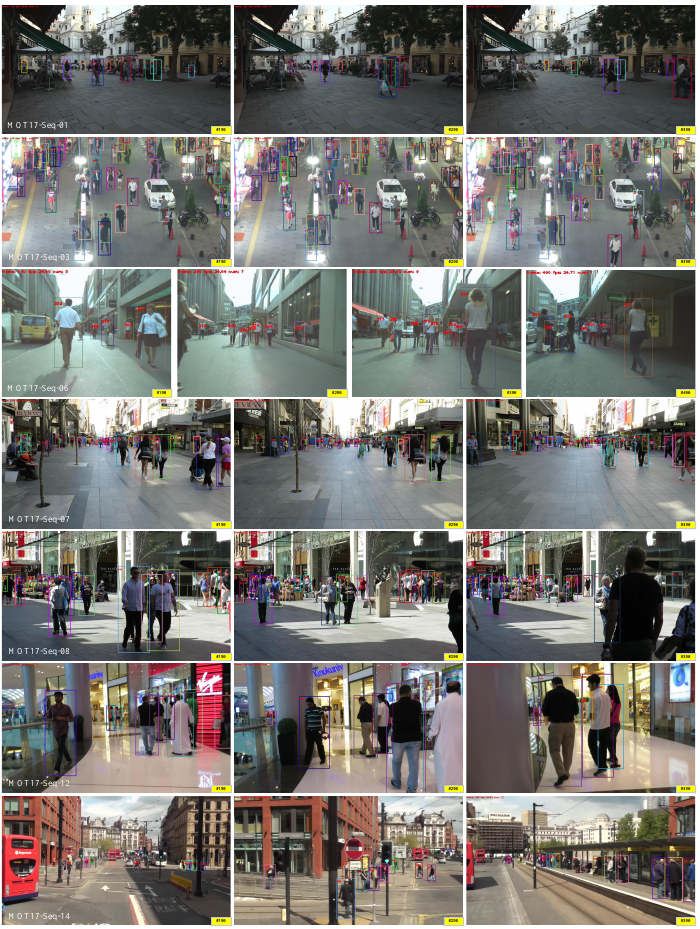
Figure 7. Tracking results of SimpleTrack on the MOT17 test dataset. The #number indicates that the frame number in mot17 video